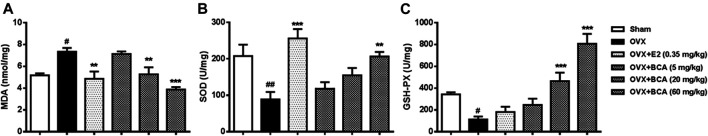
The effects of BCA on MDA (A), SOD (B), and GSH-Px (C) in hippocampal tissues of the OVX rats. The contents of MDA and activity of SOD and GSH-Px were measured in hippocampal tissues using ultraviolet spectrophotometry. BCA attenuated oxidative stress in OVX rats. Values shown are means ± S.E. #
p < 0.05, ##
p < 0.01 vs. Sham; **p < 0.01, ***p < 0.001 vs. OVX alone; n = 8.